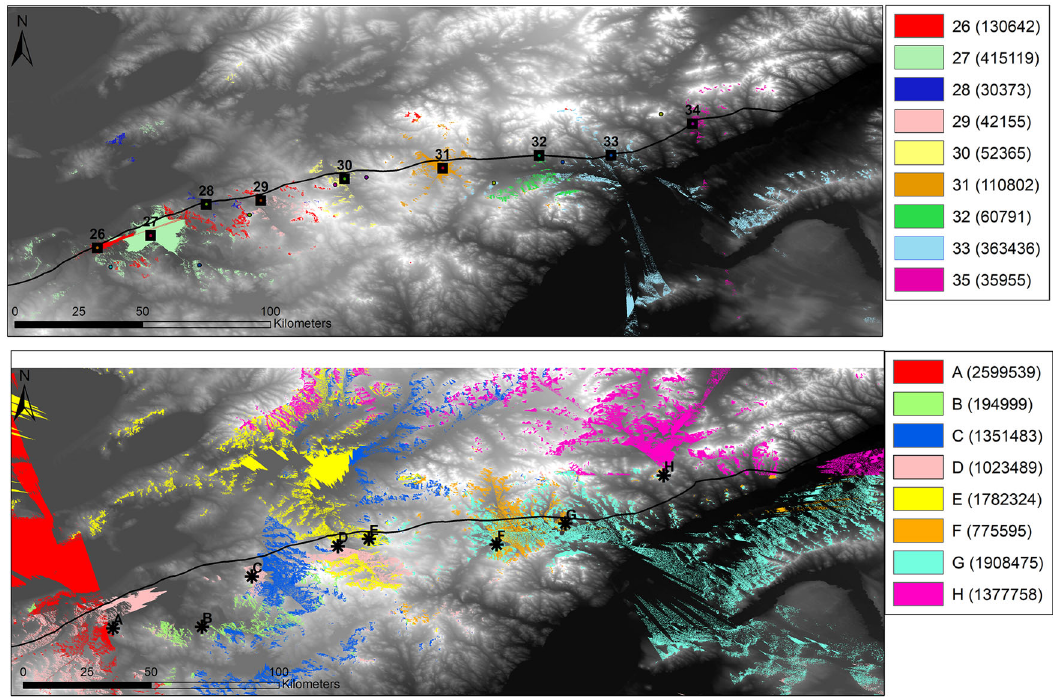
Fig. 6 Viewshed analysis of all areas visible from Clusters no. 26 – 34 (top) and those visible from eight nearby comparative points (bottom). Counts in brackets refer to the number of pixels visible from each respective